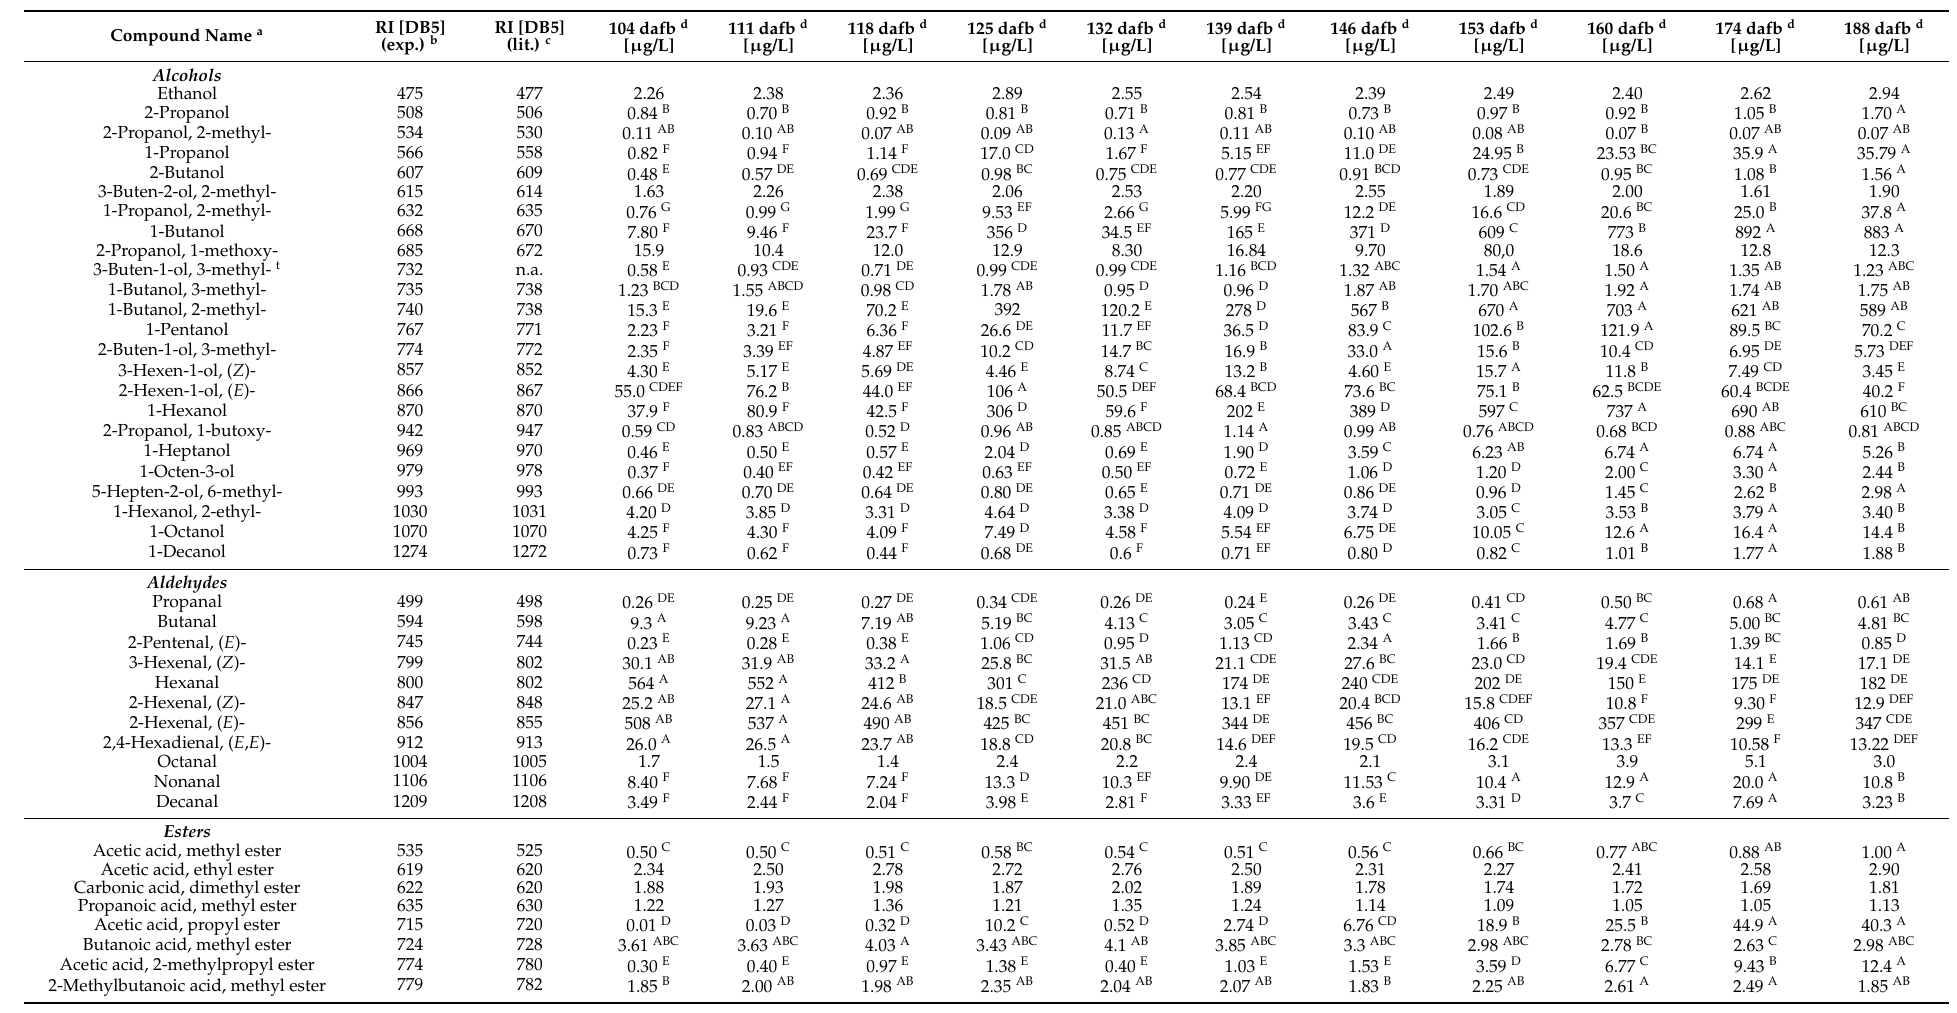
Table 3. Relative concentrations (average values ( n = 2); µ g/L) of the 2 ◦ aroma compounds identified in apple juice produced from Crimson Crisp apples harvested at different stages of maturity (104–188